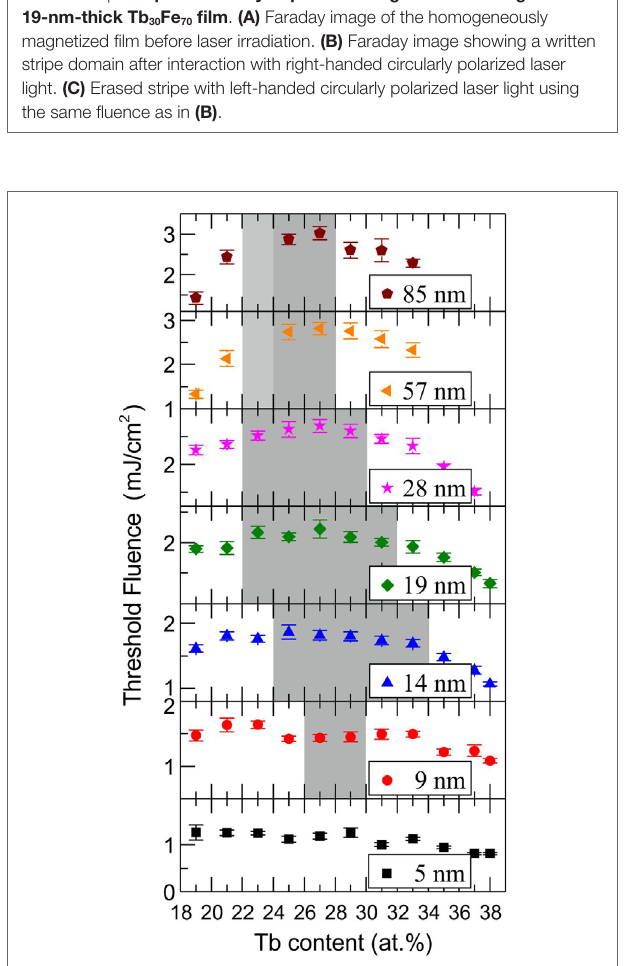
FigUre 7 | Threshold fluence for all-optical switching (dark gray color) and otherwise pure thermal demagnetization (PTD) as function of Tb content and for various Tb–Fe film thicknesses . Please note that Tb 23 Fe 77 samples with thickness of 57 and 85 nm were not investigated, however AOS is expected (light gray color).